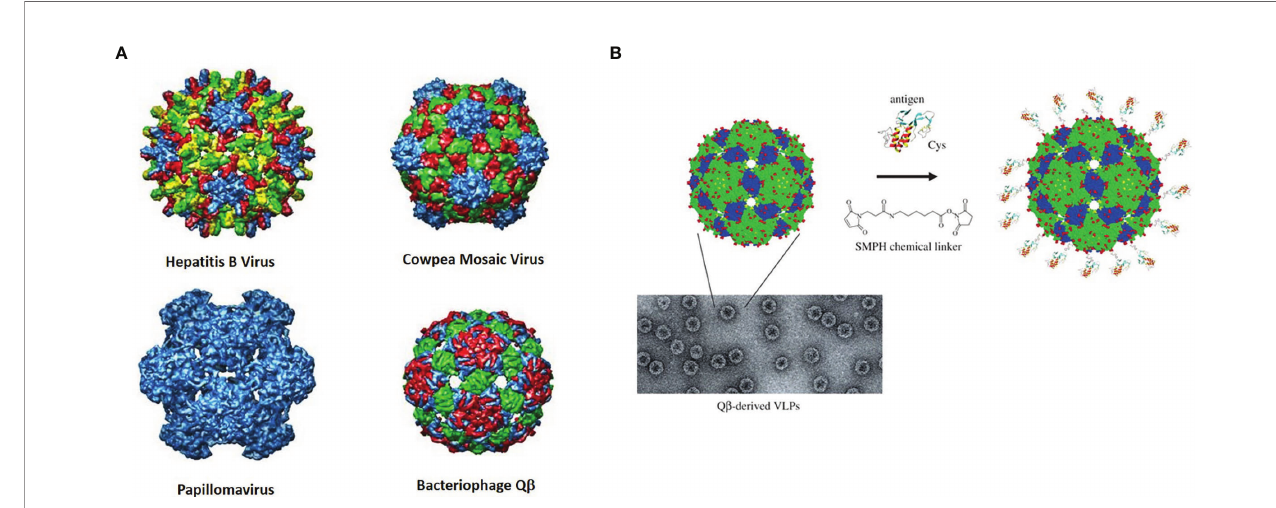
FIGURE 5 | (A) Rendered crystal structures of different VLPs with color-coded rendered subunits. (B) Depiction and micrograph of Q b and one example of how the surface may be modi fi ed with a bifunctional linker (with permission from “ Therapeutic vaccines for chronic diseases: successes and technical challenges ” 2011 , 366 , 2815-2822, DOI: